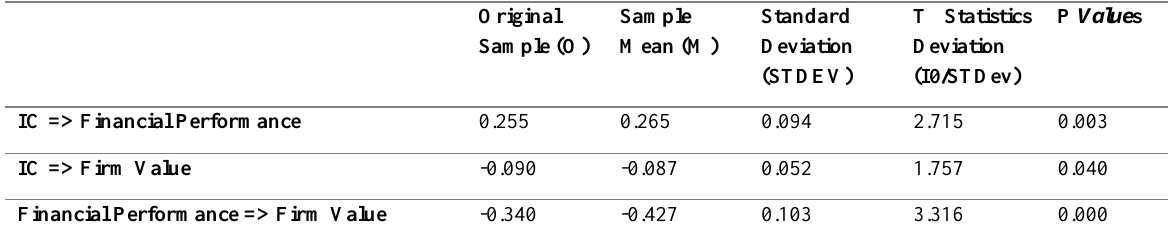
Table 2 : Output of Path Coefficients from Bootstrapping